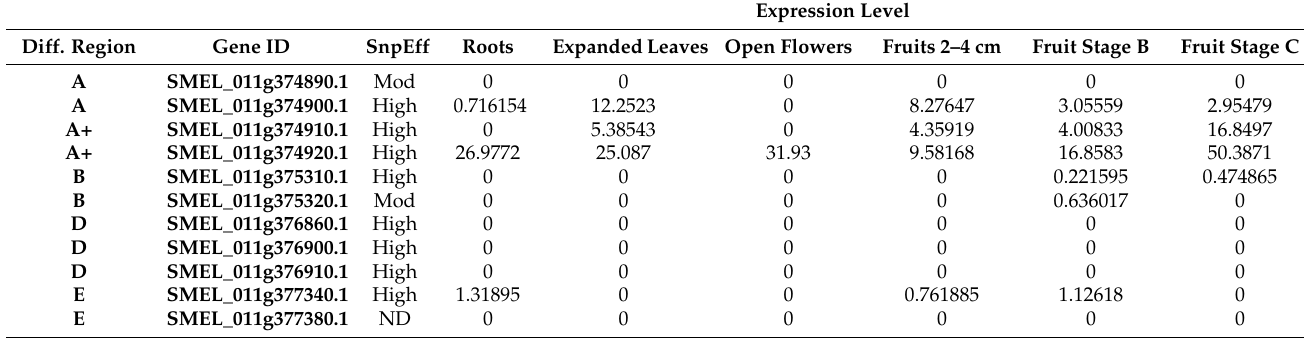
Table 5. List of the most reliable candidate genes selected within the differentially enriched regions according to SNPeff output, which suggests the severity of the effect potentially provoked by the allelic variant in the ‘305E40’ line with respect to the ‘67/3’ reference gene form. For each candidate gene, the differentially represented regions of provenance are indicated, together with the SNPeff and the expression levels in different tissues of ‘67/3’ including roots retrieved from RNAseq data already available